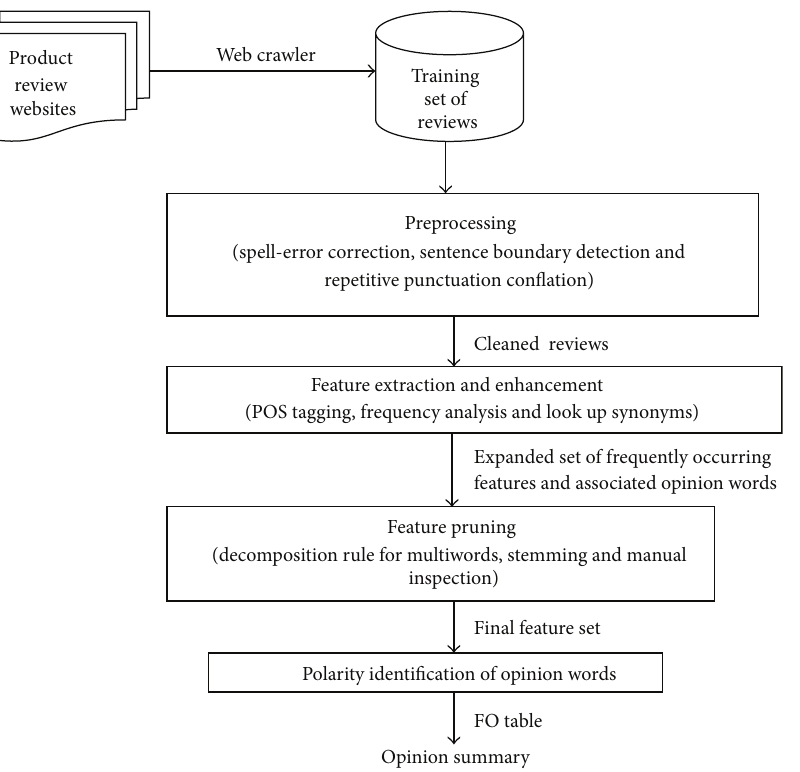
Figure 1: System design for opinion